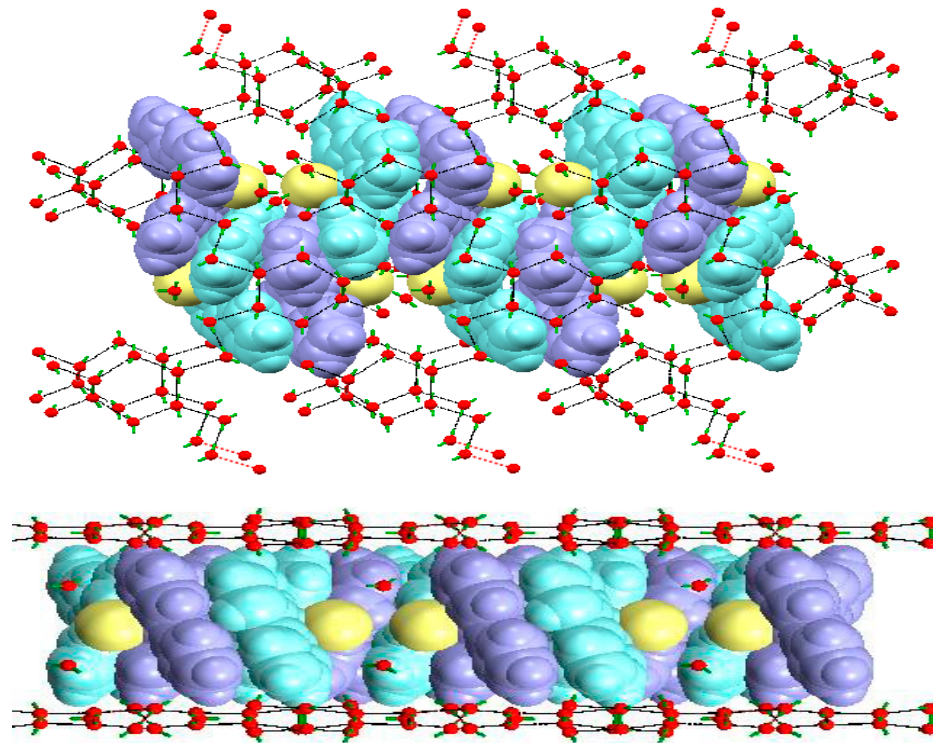
Figure 3. View along the a axis ( Top ) and c axis ( Bottom ) showing the host [CuCl(bipy) 2 ] + cations sandwiched between two nearly planar water cluster sheet. Table 1. Geometrical Parameters of Hydrogen Bonds (Å, deg) for the Water Cluster.